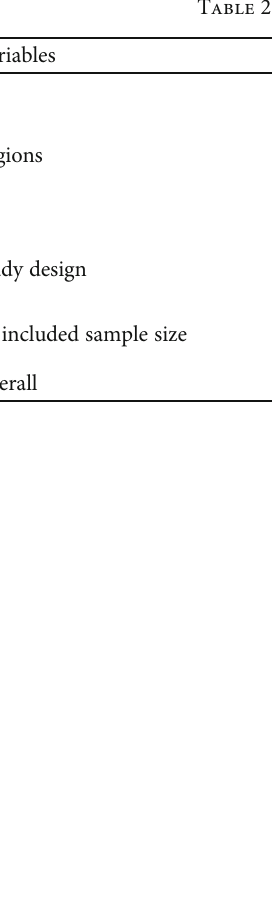
Figure 3: Funnel plot to show the distribution of 12 studies. Table 3: Metaregression analysis of neonatal sepsis with heterogeneity of neonatal